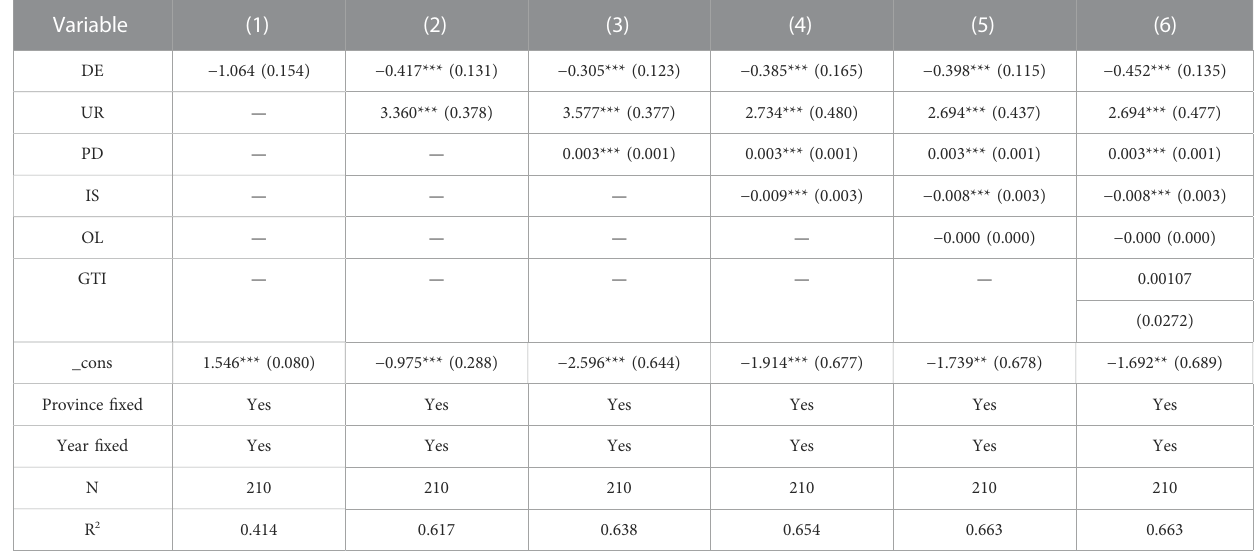
TABLE 3 Benchmark regression results.